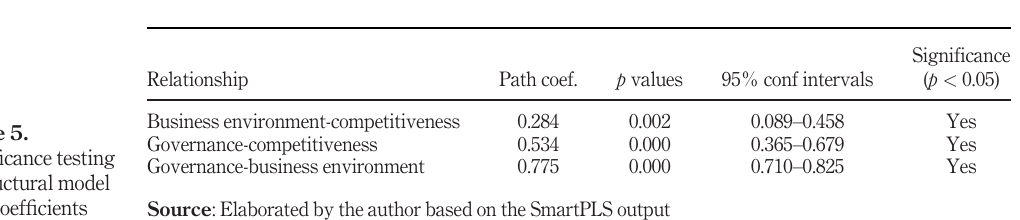
Table 5. Signi fi cance testing of structural model path coef fi